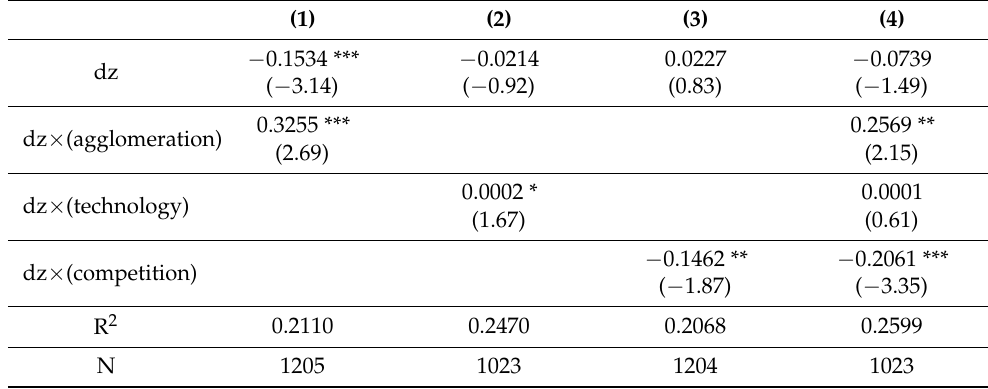
Table 8. Mechanism of the impact of the establishment on economic